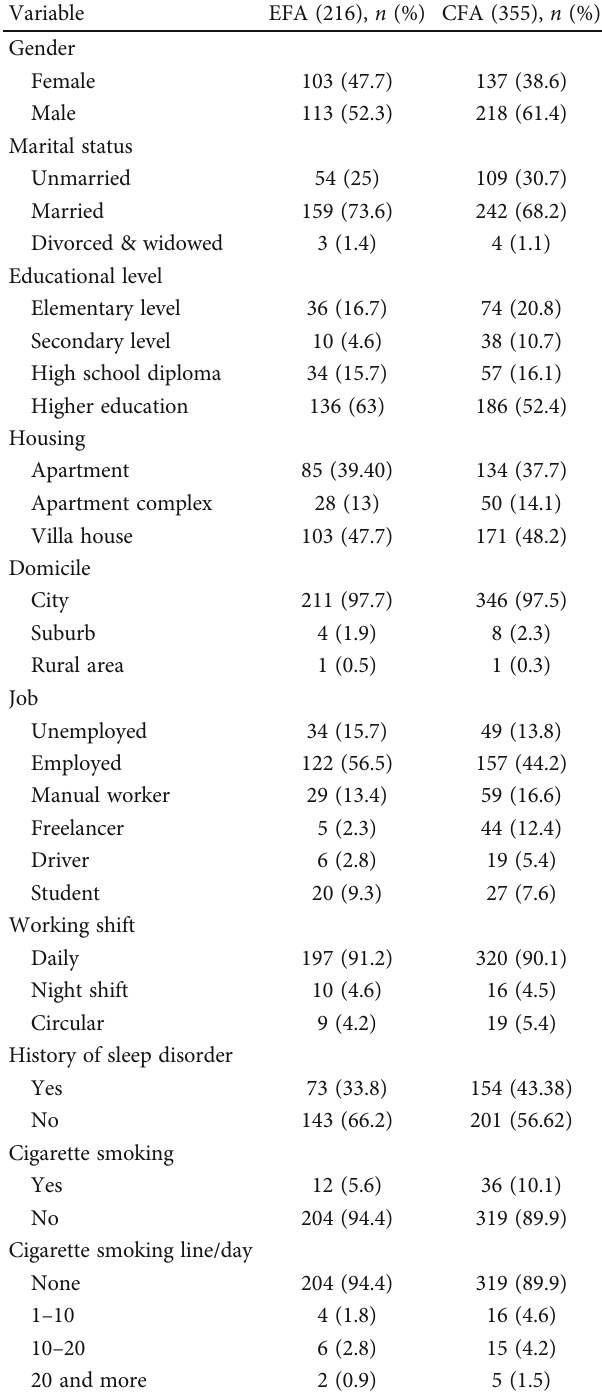
Table 1: Demographic characteristics of the study participants.